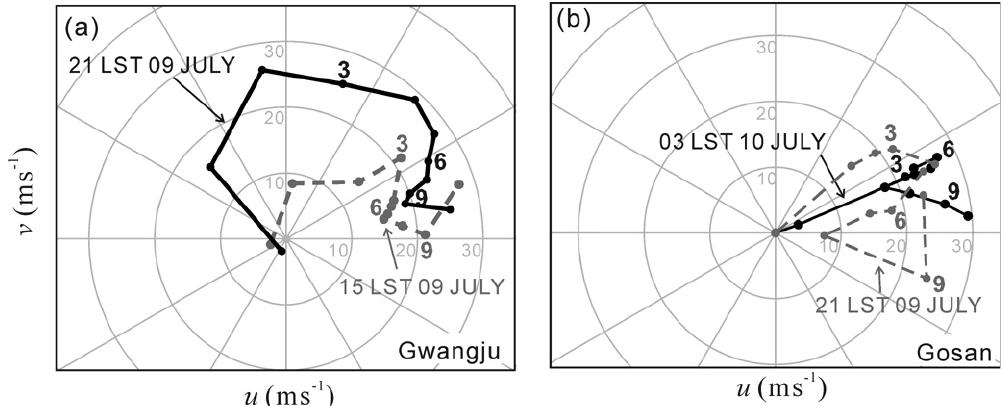
Fig. 8. Hodographs of soundings taken at (a) Gwangju and (b) Gosan (both shown in Fig. 1) at 15:00LST, 9 July and 03:00LST, 10 July 2007, respectively. The dot indicates height (dotted every 1km).